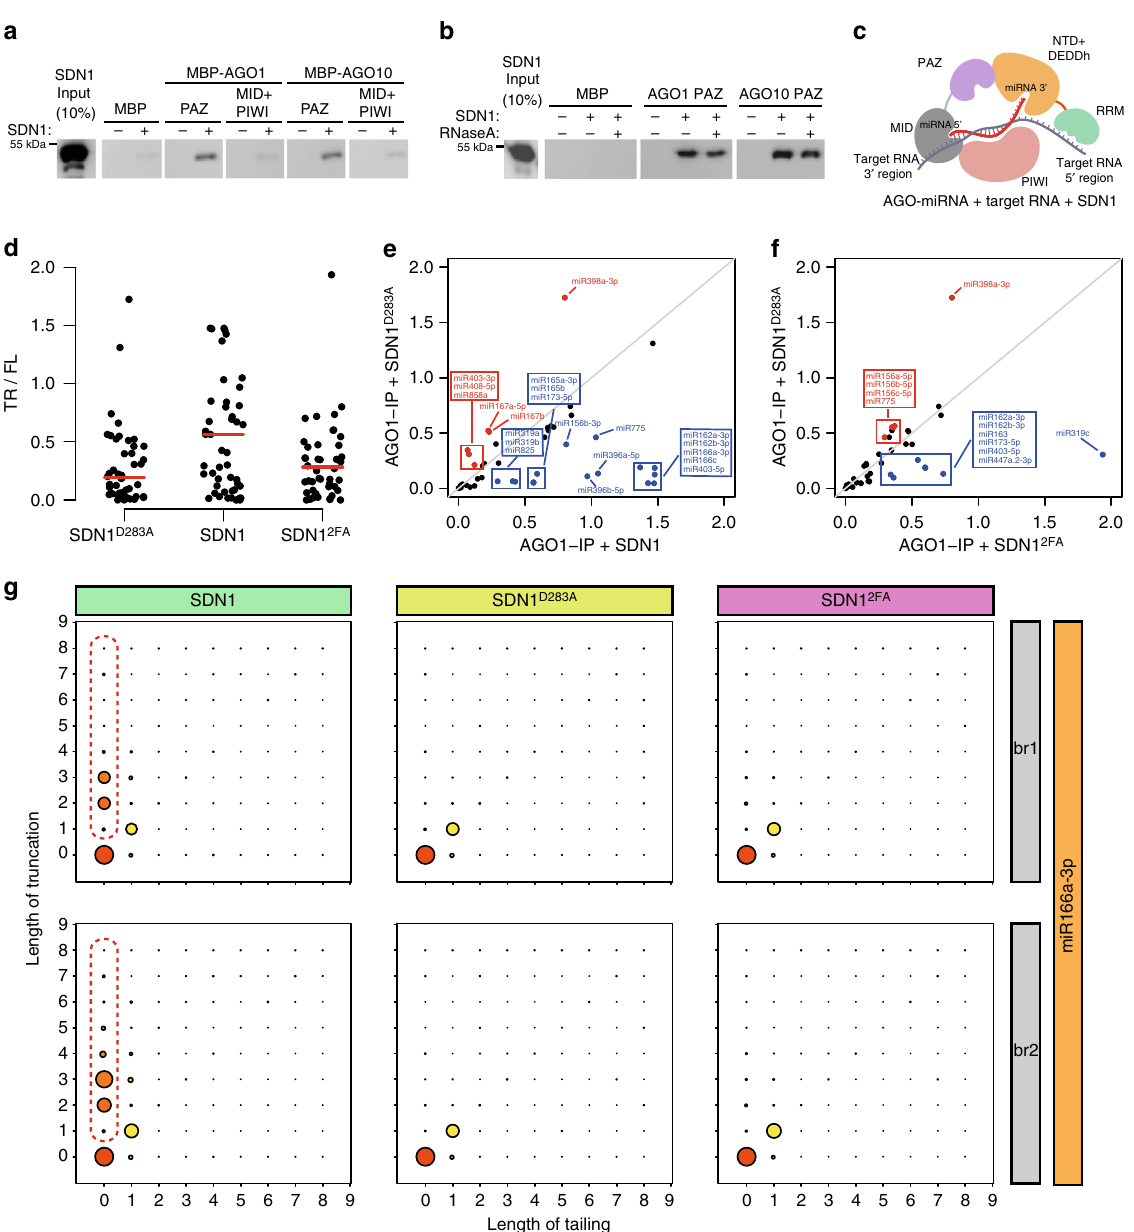
Fig. 6 SDN1 binds the AGO1 PAZ domain and triggers the 3 ′ end trimming of AGO1-bound miRNAs. a In vitro pull-down assays to determine the interaction between SDN1 and AGO1. Recombinant SDN1 was fi rst puri fi ed as His-SUMO-SDN1 followed by the removal of the His-SUMO tag. SDN1 was incubated with recombinant MBP-tagged Arabidopsis AGO1/10 PAZ or MID + PIWI on beads. Western blotting using anti-SDN1 antibodies was performed to detect SDN1 retained on beads. b In vitro pull-down assays as in a except that RNase A treatment was included to determine whether the SDN1-AGO PAZ interaction is RNA-dependent. c A model of SDN1 trimming AGO1-bound miRNAs in the presence of a target RNA. The miRNA 3 ′ end is seized by the SDN1 DEDDh catalytic pocket with the C-terminal RRM domain binding the target strand; and SDN1 interacts with the AGO1 PAZ domain to recruit SDN1 to AGO1 RISC or to facilitate the trimming process. d – g In vitro enzymatic assays on AGO1-bound miRNAs, followed by sRNA-seq to examine the 3 ′ end trimming of miRNAs. d Scatter plots showing the ratio of the 3 ′ end truncated species (TR) to the full-length species (FL) for each miRNA detected. SDN1 caused higher levels of miRNA 3 ′ truncation than SDN1 D283A or SDN1 2FA . e , f Plots showing the ratio of TR species to FL species for various miRNAs. The diagonal lines represent equal levels of 3 ′ truncated species in the SDN1 D283A and SDN1 reactions ( e ), or in the SDN1 D283A and SDN1 2FA reactions ( f ). The miRNAs marked in blue underwent SDN1-mediated 3 ′ truncation ( f ). g Diagrams showing the status of 3 ′ end truncation and tailing of miR166a-3p in two biological replicates (br1 and br2). The y -axis represents the number of nucleotides truncated from the 3 ′ end. The x -axis represents the number of nucleotides added to the 3 ′ end. The size of the circles indicates the relative proportions of the species. The truncated forms of miR166a-3p generated by wild-type SDN1 are highlighted in red dashed